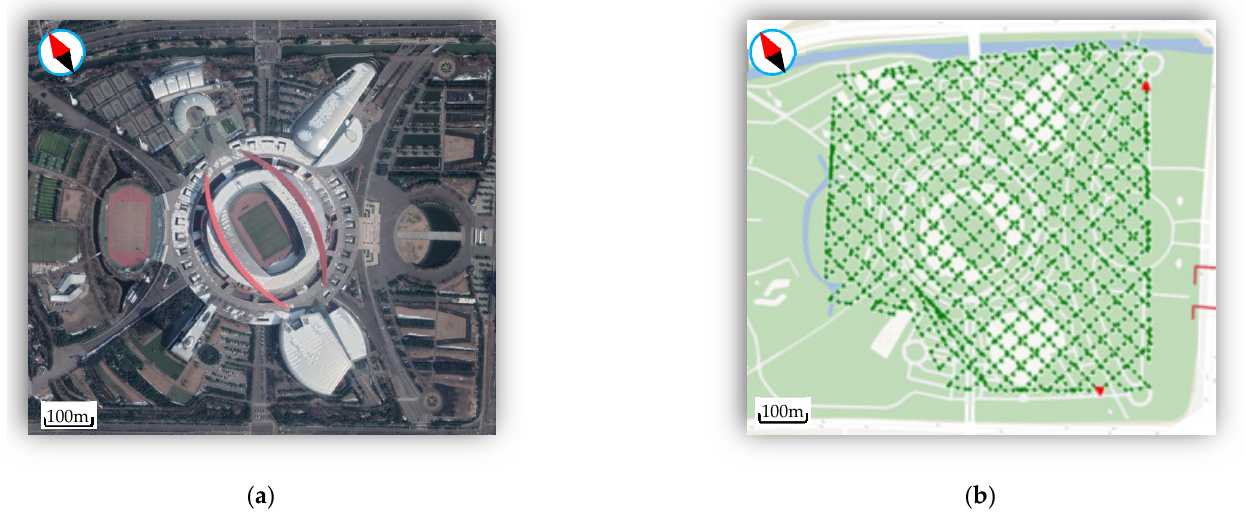
Figure 4. ( a ) Landscapes of the data acquisition site; ( b ) Shooting position distribution of the collected drone images.